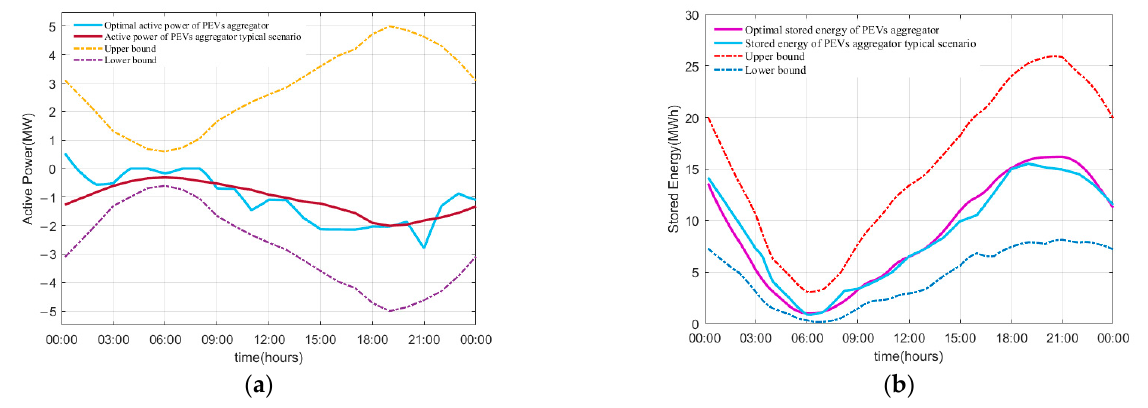
Figure 14. ( a ) Total active power. ( b ) Total stored energy of the PEVs aggregate battery.